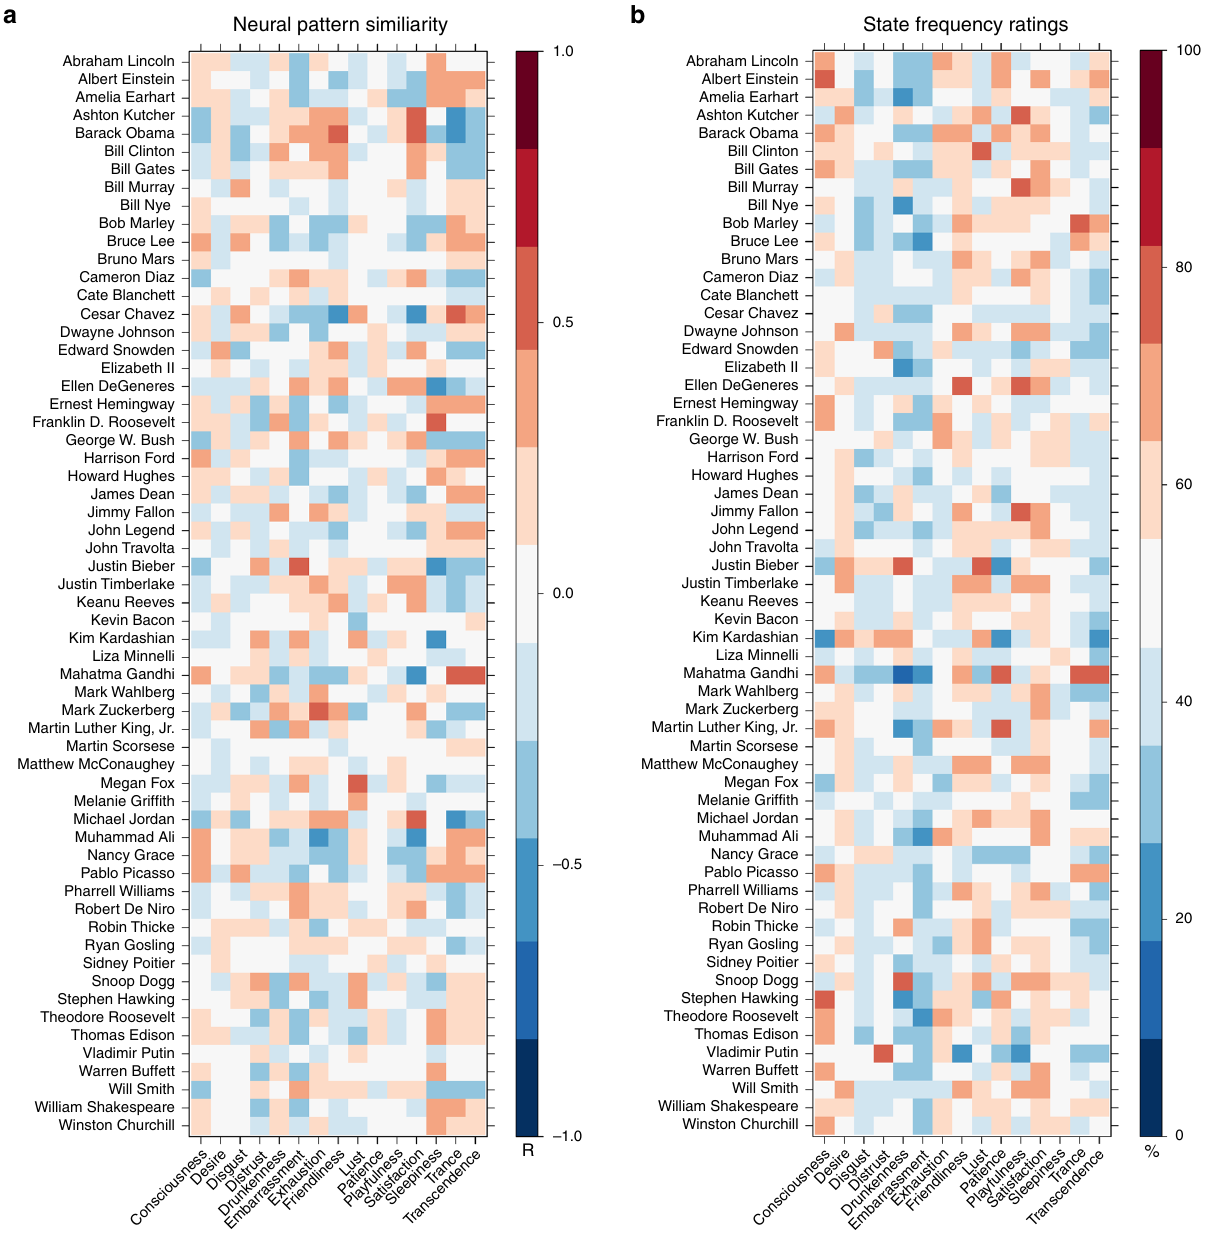
Fig. 4 Neural pattern similarity between people and mental states, and corresponding summed states. a Similarity between person-speci fi c and state- speci fi c patterns of brain activity from two imaging experiments were calculated by correlating voxelwise values across the regions selected for containing reliable person representations. b Behavioral ratings of how often each person experienced each state were provided by independent online raters. These ratings were sum-normalized within state prior to warmth, competence, trustworthiness, dominance, openness, conscientiousness, extraversion, agreeableness, neuroticism, intelligence, and attractiveness. All but the last two of these dimensions were taken from existing theories of person perception 13,25 – 29 . These dimensions were reduced to an optimal three- dimensional synthesis — consisting of power, valence, and sociality — via principal component analysis (PCA). The resulting synthesis outperformed any of the ori- ginal trait theories of person perception in predicting patterns of brain activity 15 , and so we adopted it here for the purpose of providing the strongest trait theory against which to compare the summed state hypothesis. Voxel selection . GLM-derived person-speci fi c patterns and state-speci fi c patterns served as the basis for all fMRI analyses. However, not all portions of the brain represent social information, and thus we performed voxel selection to limit the analyzed patterns to the social brain network. This network was de fi ned as mask of 10,216 non-contiguous voxels implicated in social cognition 15 ; these voxels